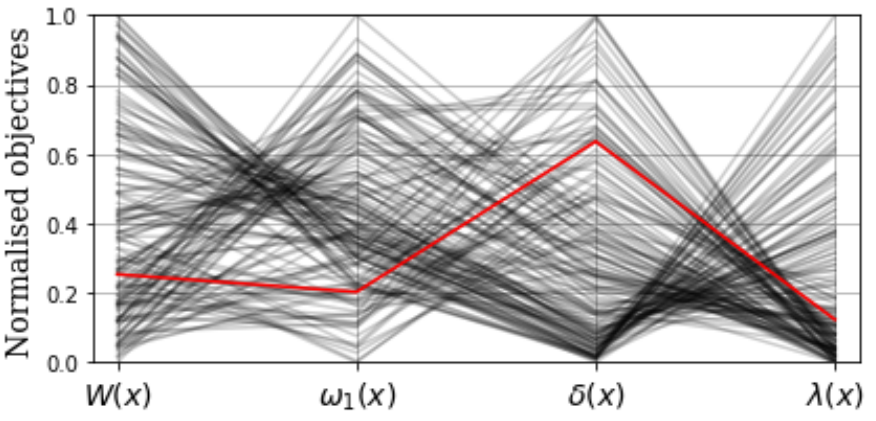
Figure 16. Parallel coordinates plot of the PF obtained for MOSOP3.